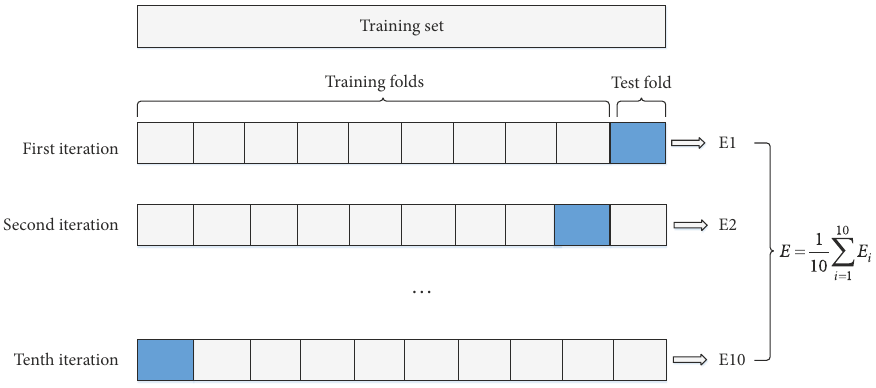
Training set Training folds Test